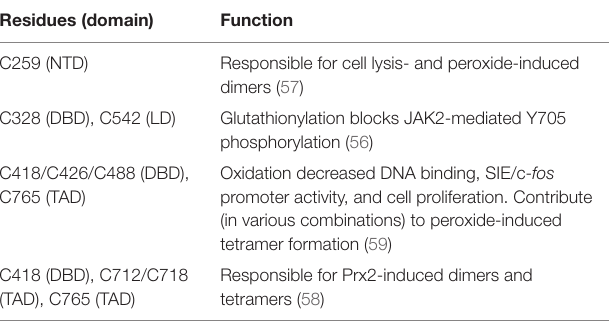
TABLe 2 | Redox-sensitive cysteines of